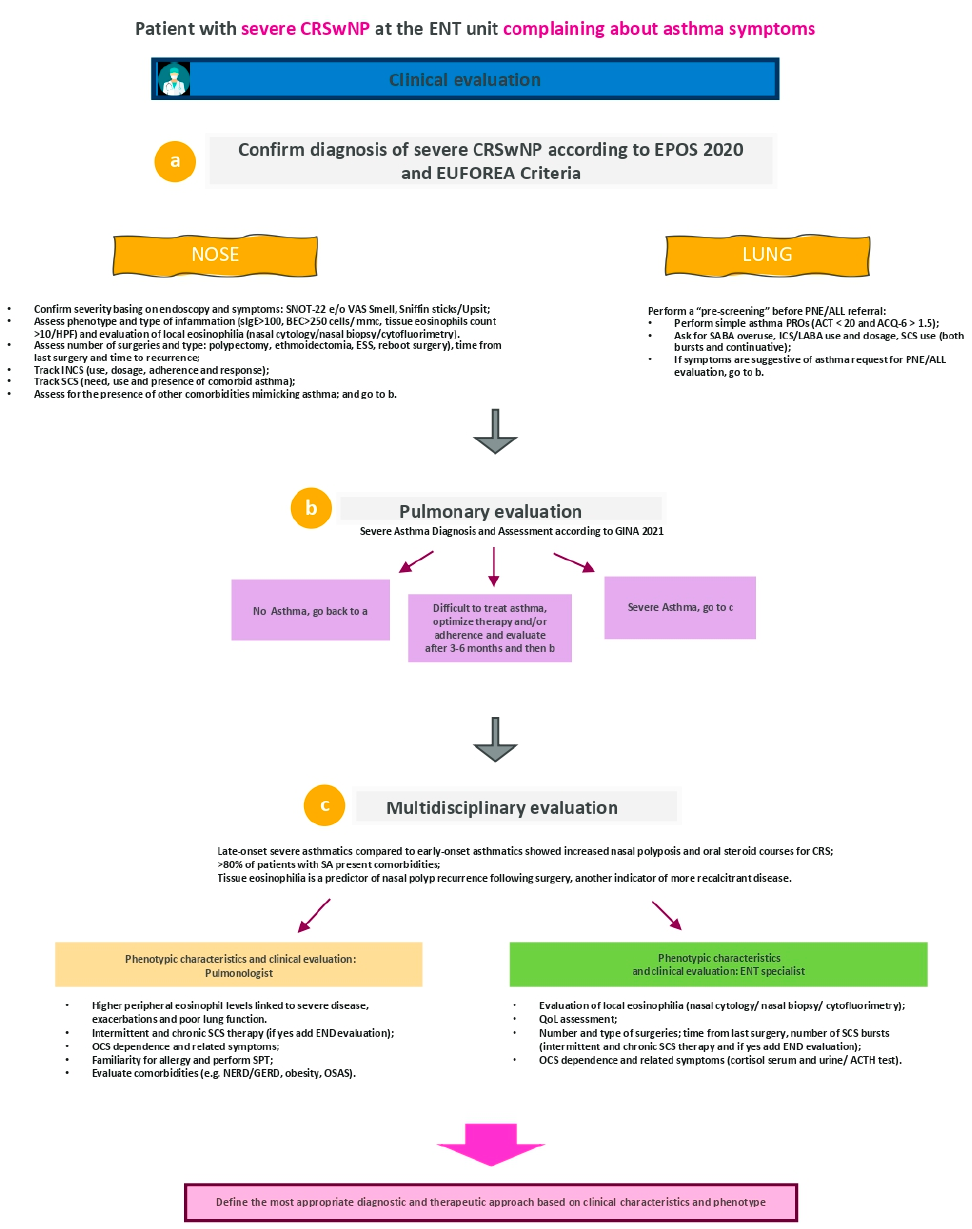
Figure 6. CRSwNP = chronic rhinosinusitis with nasal polyps; EPOS = European Position Paper on Rhinosinusitis and Nasal Polyps; SNOT-22 = sino-nasal outcome test on 22 items; NPS = nasal polyps score; sIgE = serum immunoglobulin E; BEC = blood eosinophil count; HPF = high power field; SCS = systemic corticosteroids; GERD = gastro-esophageal reflux disease; OSAS = obstructive sleep apnea syndrome; SABA = short-acting beta-2 agonists; PROs = patient-reported outcomes; ACT = asthma control test; ACQ-6 = asthma control questionnaire on 6 items; GINA = Global Initiative for Asthma; SPT = skin prick test; CRS = chronic rhinosinusitis; PNE = pulmonologist; INCS = inhaled corticosteroids; NERD = Non-erosive reflux disease; GERD = gastroesophageal reflux disease; OSAS = obstructive sleep apnea syndrome; END =